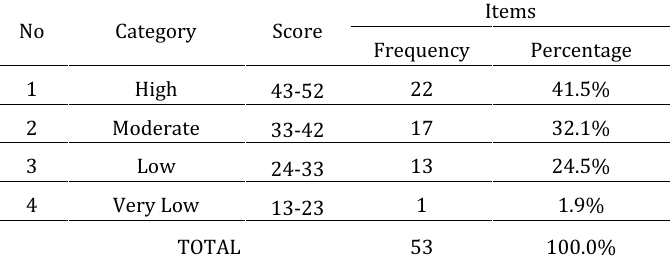
Categories of items on parenting problems and